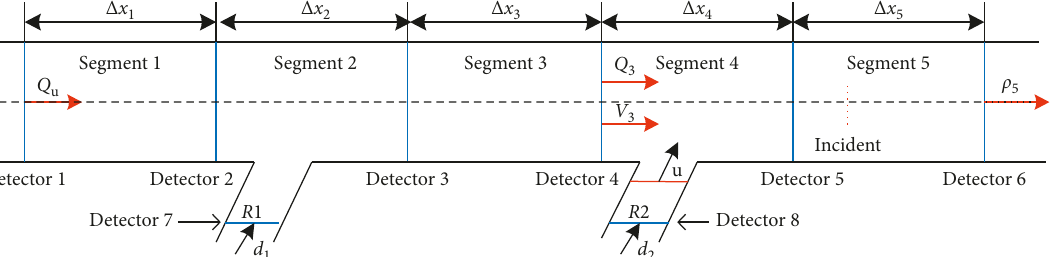
Figure 3: Hypothetical freeway stretch.